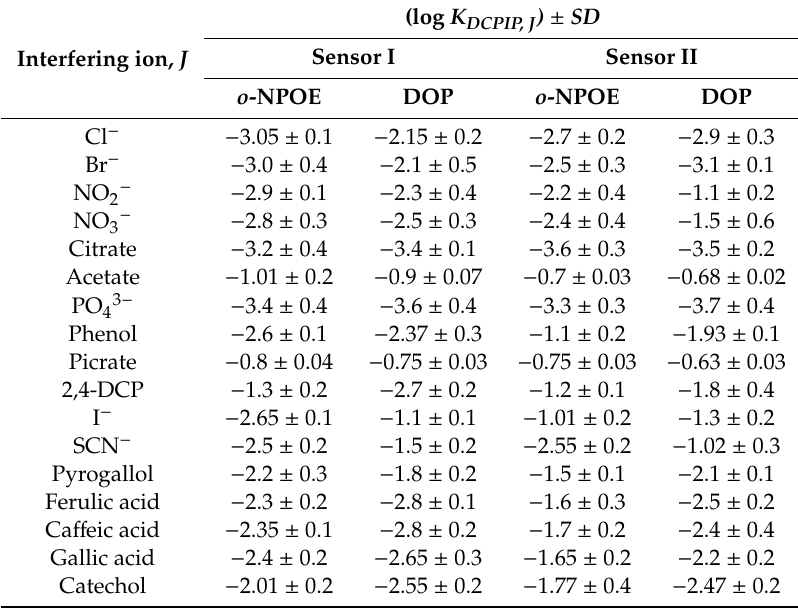
Table 3. Selectivity coe ffi cients (log K DCPIP, J ) ± SD obtained for the proposed sensors. (log K DCPIP, J ) ± SD Sensor I Sensor II Interfering ion, J o -NPOE